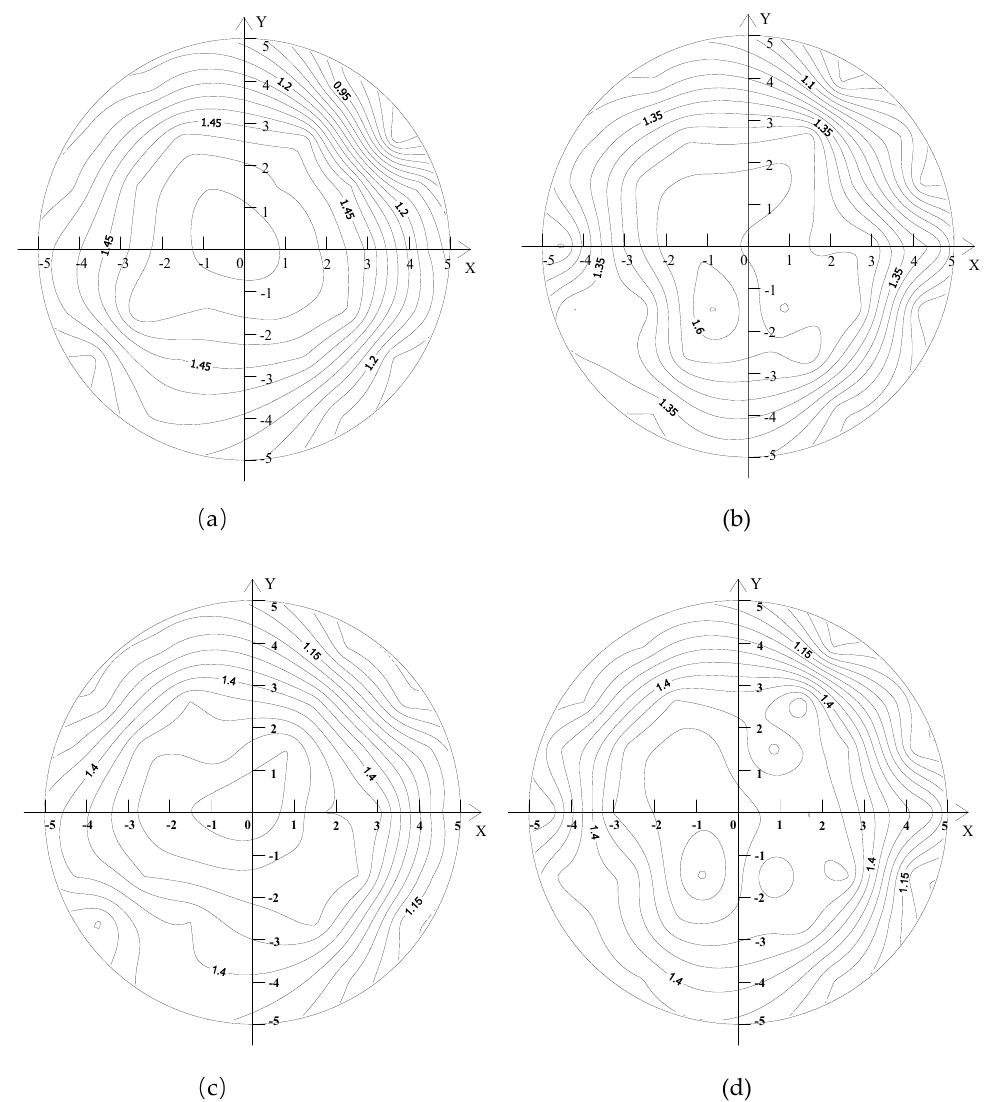
Figure 5. Axial velocity distributions of the upstream sections of capsules: ( a ) L / d = 2.5, Z = 3 m; ( b ) L / d = 2.14, Z = 3 m; ( c ) L / d = 2.5, Z = 0.1 m; and ( d ) L / d = 2.14, Z = 0.1 m.